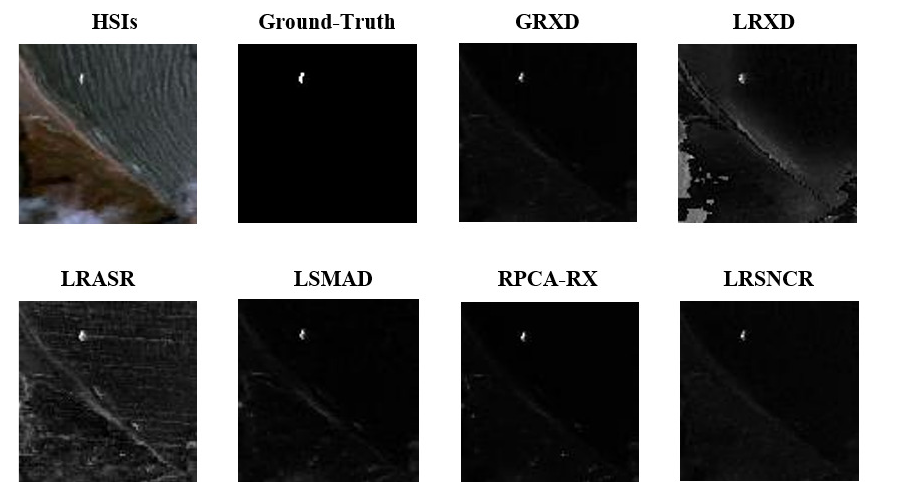
Figure 17. Detection maps by ABU-beach dataset.